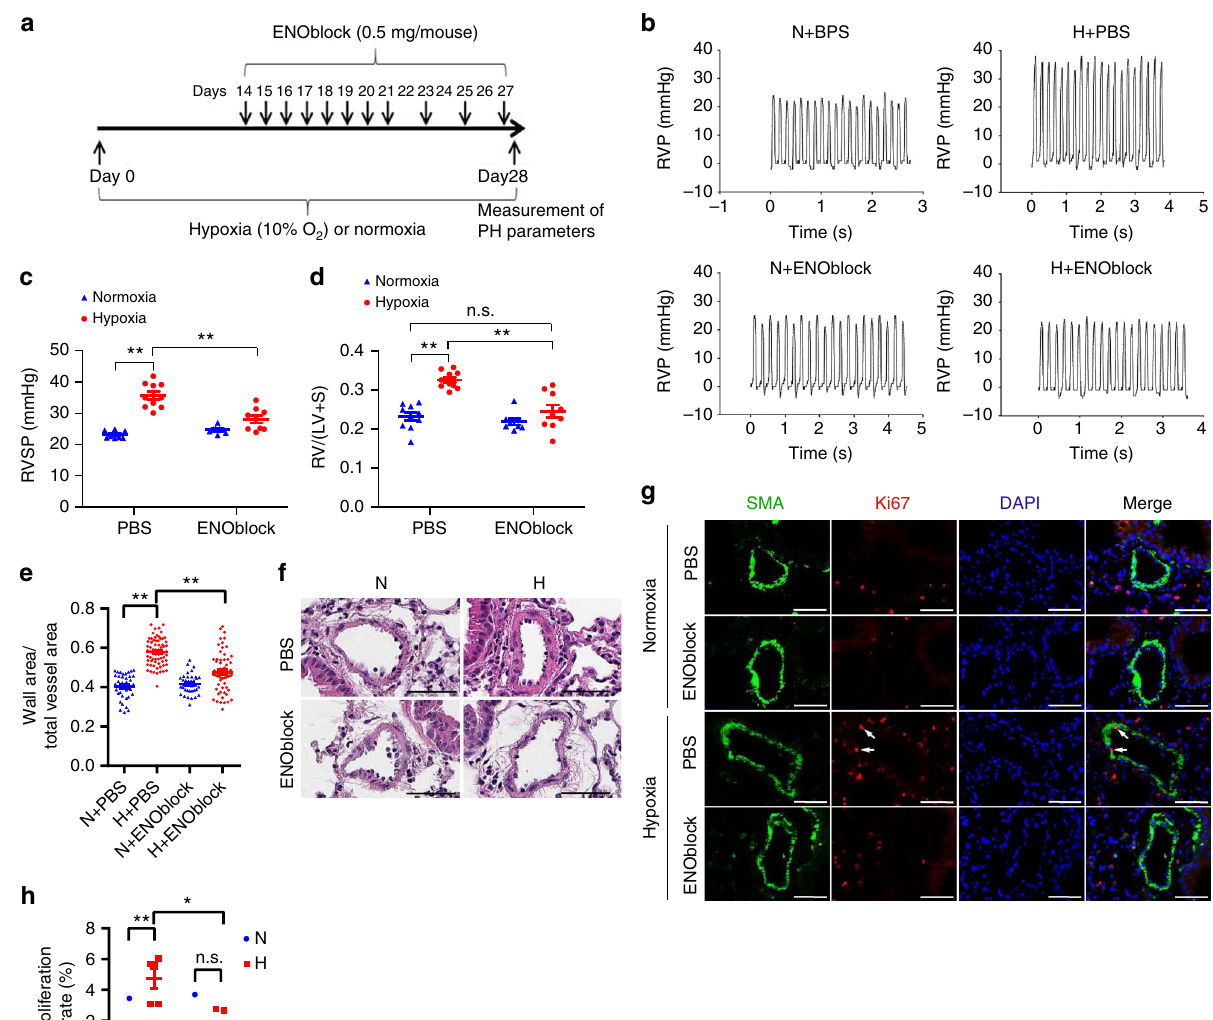
Fig. 7 ENOblock reverses hypoxia-induced PH in mice. a A diagrammatic sketch depicts the hypoxia-induced PH mice model and ENOblock treatment protocol ( n = 8 – 10 per group). C57BL/6 J mice were exposed to normoxia or hypoxia (10% O 2 ) for 2 weeks before the ENOblock treatment. During the treatment period, the mice were continuously exposed to normoxia or hypoxia and received 0.5 mg/day/mouse ENOblock treatment via intraperitoneal injection for 2 weeks (one injection per day in the fi rst week and one injection every other day in the second week). After the ENOblock treatment, we analyzed and calculated RVSP c ( n = 8 – 10 per group, ** P < 0.01), right ventricular hypertrophy d ( n = 8 – 10 per group, ** P < 0.01), and pulmonary artery remodeling e (** P < 0.01). The representative tracings of RVP are shown in b and the representative pulmonary artery images (HE staining) in the lung sections of experimental mice are shown in f (Scale bars, 50 μ m). g The lung sections of mice from each group were co-immunostained with SMA and Ki67 antibodies and DAPI (Scale bars, 50 μ m). The white arrows indicate the proliferating PASMC and h the proliferation rates of PASMCs were quanti fi ed in each group. Data represent the mean ± SEM. Student t test and one-way ANOVA were used to compare two and multiple groups. Bonferroni post-tests were carried out after further test the therapeutic effects of ENOblock in PH, we right ventricular systolic pressure (RVSP) (Fig. 7b – c), the right also adopted the ENOblock treatment in the SuHx-induced rat ventricle/(left ventricle + septum) (RV/(LV + S)) ratio (Fig. 7d), model of PH (Fig. 8a). ENOblock did not change the basal levels and pulmonary arterial wall thickness (Fig. 7e, f) without sig- of PH parameters in normoxic rats (Fig. 8b – e). However, ENO- ni fi cant changes in the basal levels of these parameters in nor- block attenuated the SuHx-induced development of PH as moxic conditions. ENOblock dramatically inhibited hypoxia- assessed by the inhibition of RVSP (Fig. 8b), RV/(LV + S) ratio induced hyper-proliferation (Ki67 immunostaining) in vivo (Fig. 8c) and pulmonary arterial wall thickness (Fig. 8d – e). Ki67 (Fig. 7g, h). These results suggest that the inhibition of ENO1 and SMA co-immunostaining showed that ENOblock treatment with ENOblock reverses hypoxia-induced PH in vivo. inhibited hypoxia-induced PASMC hyper-proliferation in vivo (Fig. 8f, g). To address whether ENOblock inhibits PH via inhibition on ENOblock reverses Sugen/hypoxia-induced PH in rats . Com- AMPK/Akt, we tested the effects of ENOblock treatment on the bination of the Sugen 5416 injection and hypoxia exposure AMPK/Akt activation in SuHx-induced PH rats. ENOblock (SuHx) induces a much more profound PH phenotype in rats. To